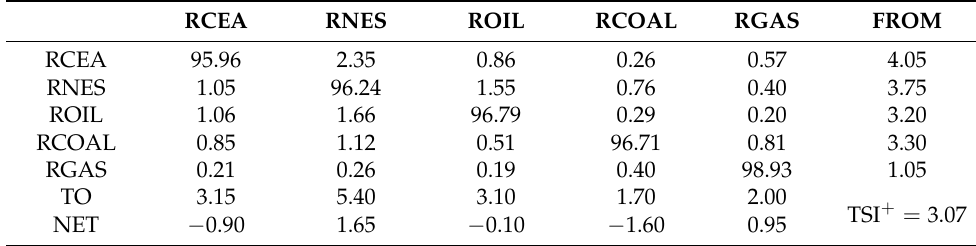
Table 4. The connectedness matrix of the positive return system.